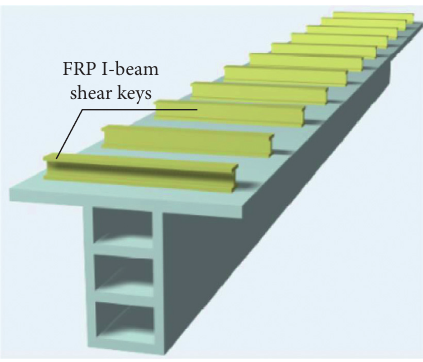
Figure 19: FRP shear keys type.